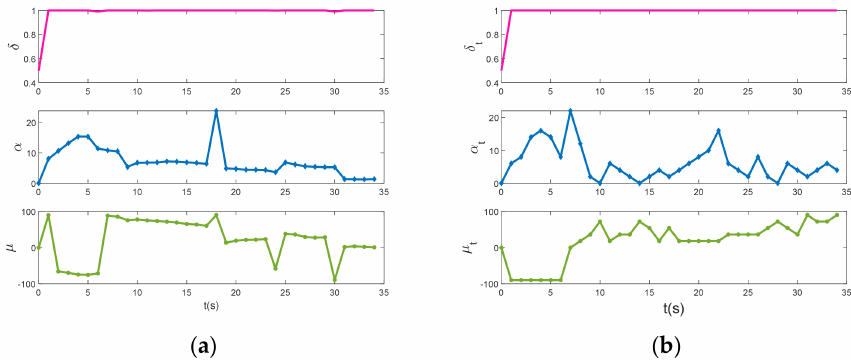
Figure 13. Decision process control variable curve. ( a ) UCAV; ( b ) enemy.